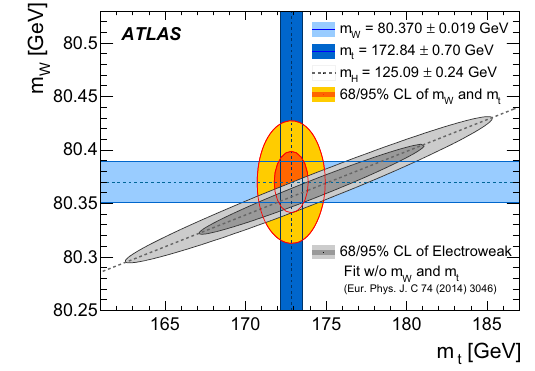
Fig. 30 The 68 and 95% confidence-level contours of the m W and m t indirectdeterminationfromtheglobalelectroweakfit[16]arecompared to the 68 and 95% confidence-level contours of the ATLAS measure- ments of the top-quark and W -boson masses. The determination from the electroweak fit uses as input the LHC measurement of the Higgs- boson mass, m H = 125 . 09 ± 0 . 24GeV [123]